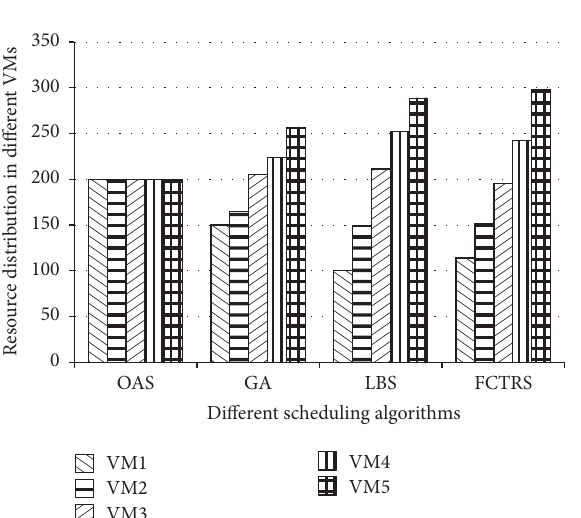
Figure 7: The prediction results and error.